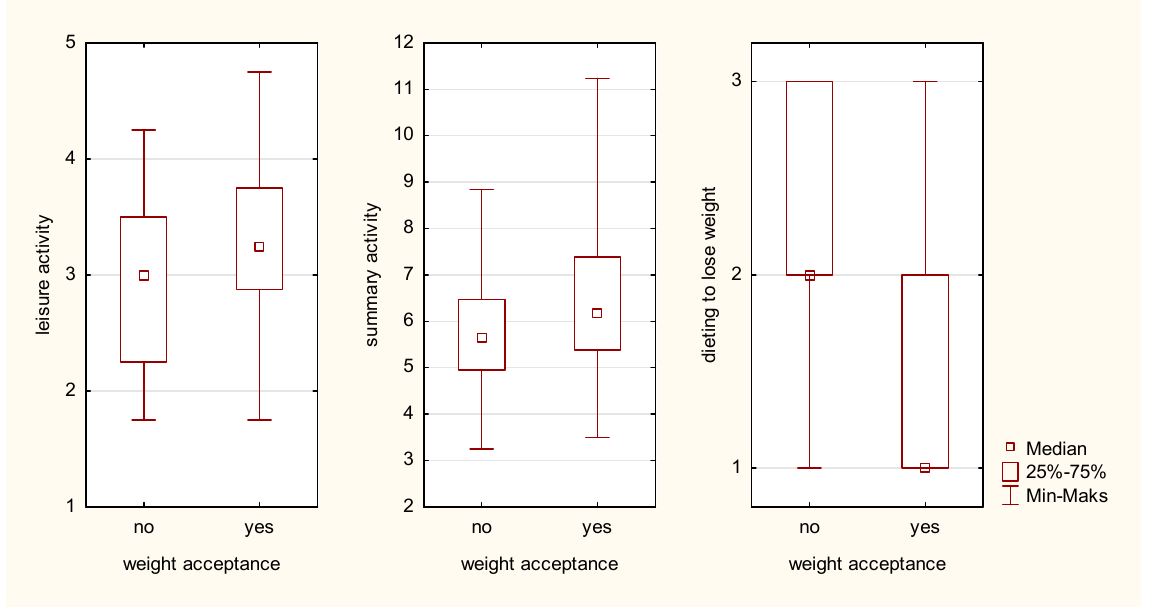
Figure 2. Comparison of girls not accepting their body mass and girls accepting their body mass.